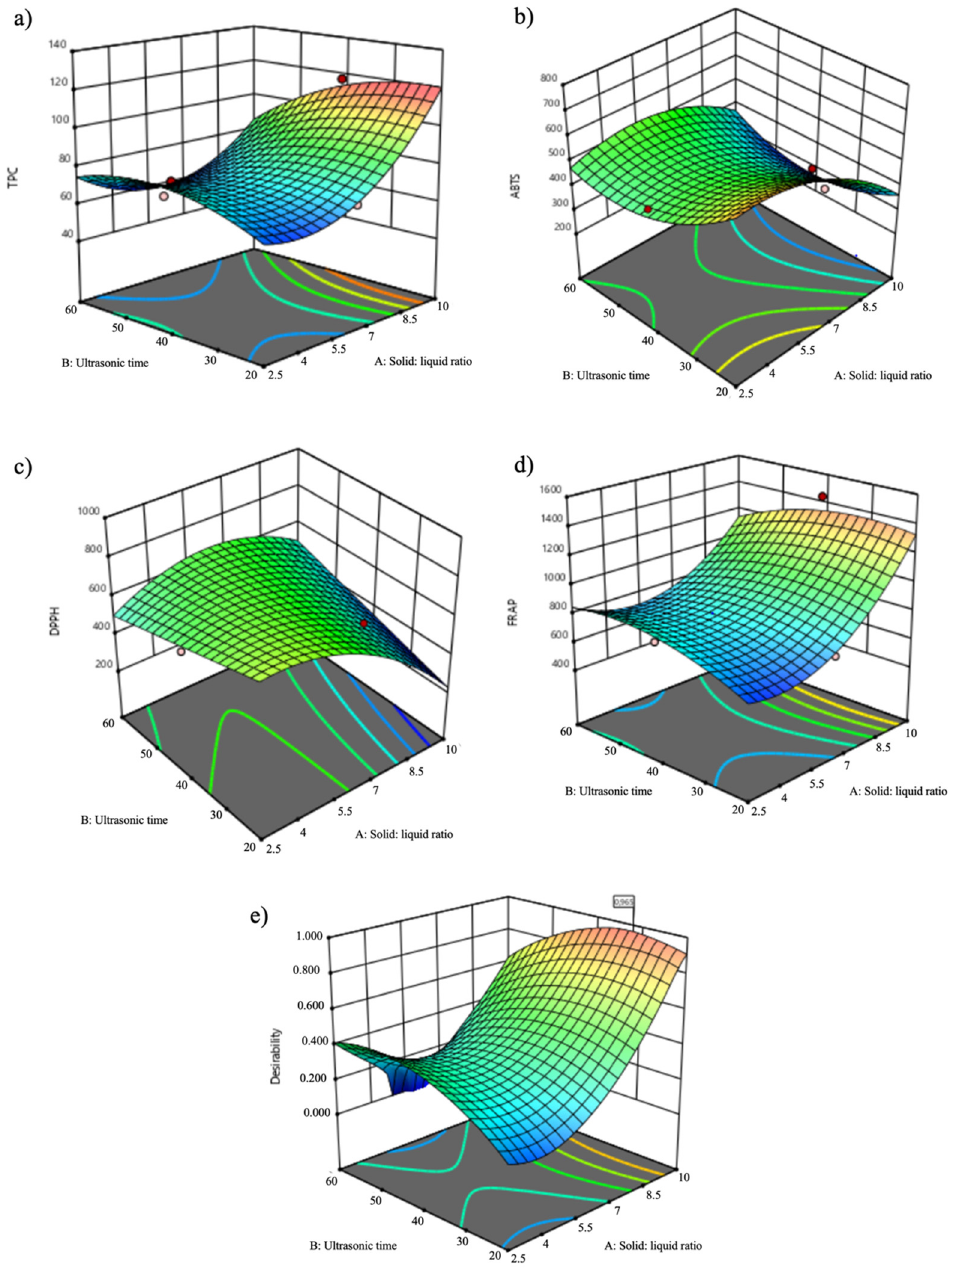
Figure 1. Response surface plots for interaction effects of solid:liquid ratio (% w / v ) and time (min) on TPC ( a ), ABTS ( b ), DPPH ( c ) and FRAP ( d ) extraction and on the desirability index for combined responses of UAE and kiwiberry leaf extracts at fixed intensity (30 W/m 2 ) ( e ).